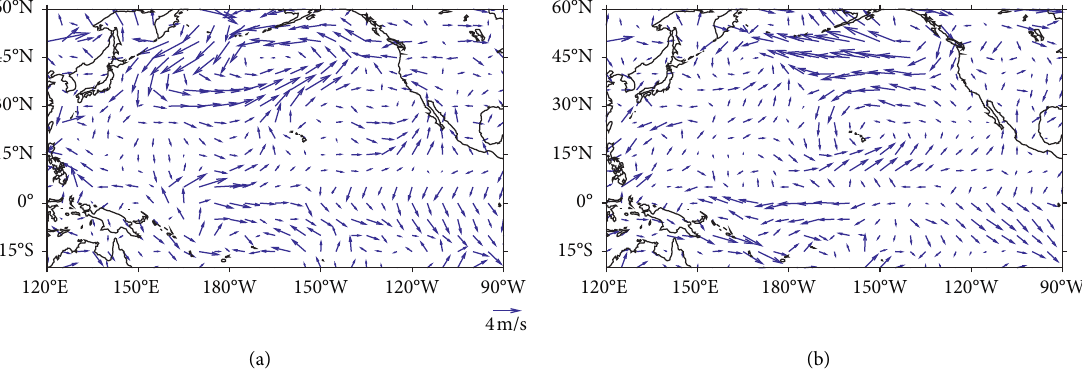
Figure 12: Differences of the winter (November-March) mean surface wind between the warm PDO phases and cool PDO years from developing (a) to decaying (b) CP El Niño years.